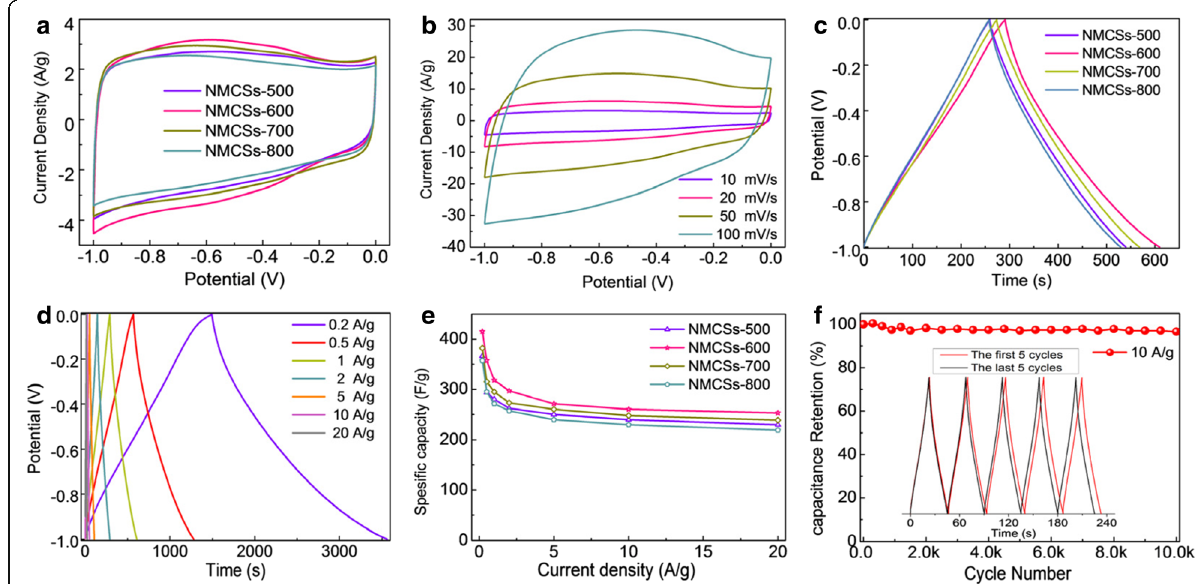
Fig. 4 ( a ) CV curves of NMCSs electrodes at scan rate of 10 mV s − 1 , ( b ) CV curves of the NMCSs-600 electrode at different scan rates from 10 to 100 mV s − 1 , ( c ) GCD curves of NMCSs electrodes at current density of 1 A g − 1 , ( d ) GCD curves of the NMCSs-600 electrode at different current densities, ( e ) Specific capacitance of NMCSs electrodes as a function of current densities, and ( f ) Cycling performance of the NMCSs-600 electrode at current density of 10 A g − 1 for 10,000 cycles and the inset shows the GCD curves of the first five and last five cycles, with a three-electrodes system in 6 M KOH aqueous